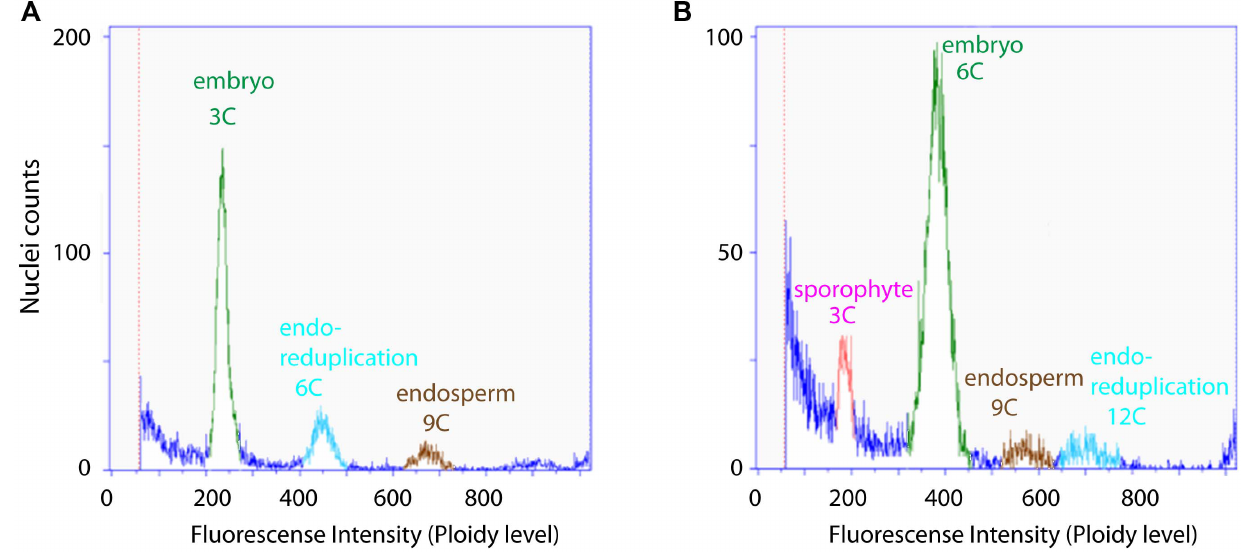
Figure 1. Flow cytometric seed screen on single seeds of Boecheragunnisoniana to analyse ploidy. Fluorescence intensity was measured on individual green seeds of Boechera to determine the ploidy level of embryo and endosperm. 98% of the seeds measured (N=84) showed a 3C:9C ratio of embryo:endosperm, indicating diplosporous apomixis (A). The remaining 2% showed a 6C:9C embryo:endosperm ratio indicative of a BIII hybrid where the embryo is derived from fertilization of an unreduced egg cell